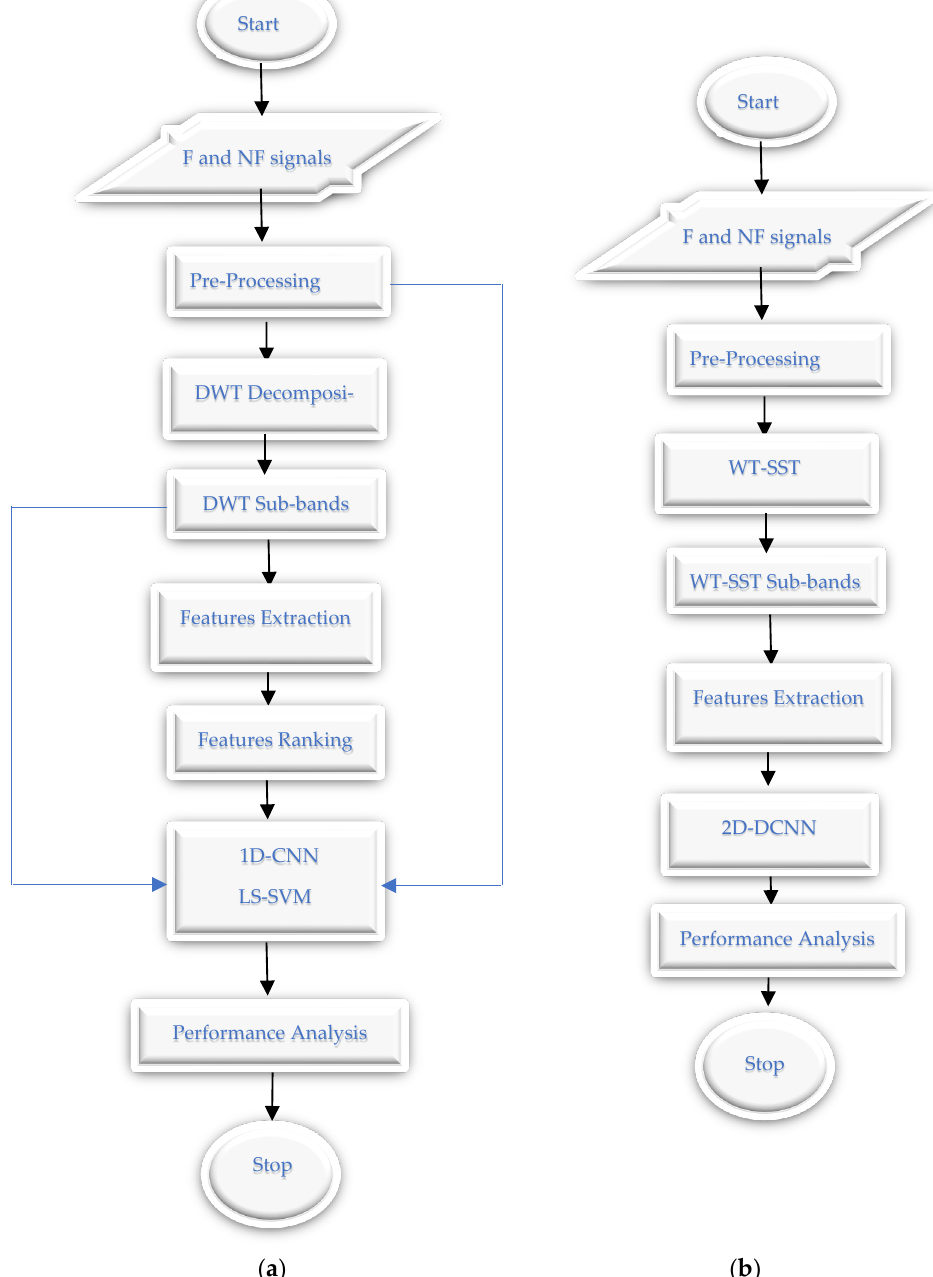
Figure 5. Block diagram of the proposed techniques, ( a ) classification of focal and non-focal EEG signals using DWT and hybrid features with SVM and 1D-CNN. ( b ) using WT-SST time-frequency matrix features with 2D-DCNN.